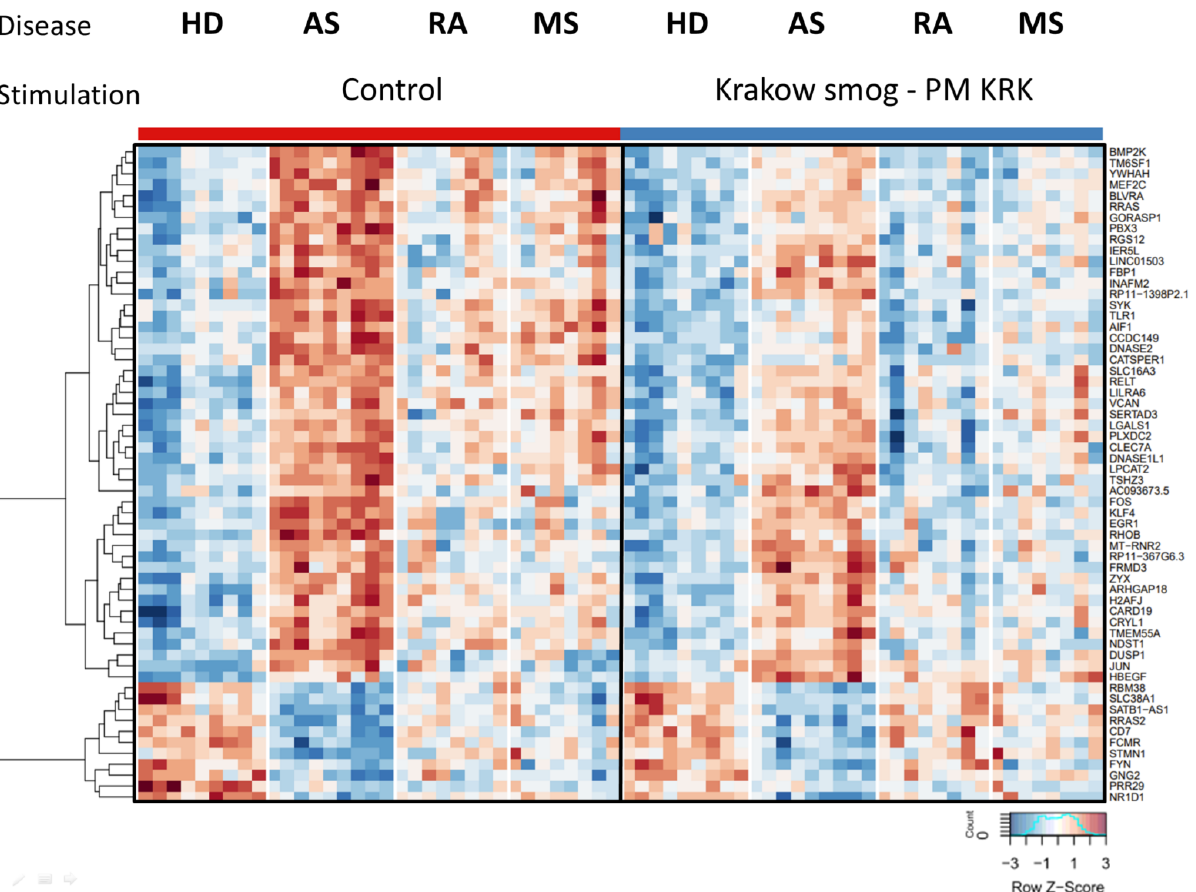
Figure 4. Gene expression differences between the response of PBMCs derived from HD, RA, MS, and AS to PM KRK treatment. RNAseq results are shown as a heatmap and include transcripts with a genome-wide significance from two-way ANOVA for the interaction (FDR corrected p < 0.01) and the difference between disease or stimulation group vs. the appropriate control (a fold of change log 2 > 1). The intensity of the coloured rectangles represents transcript abundance levels. The presented level is proportional to the row z-score values (between − 3 and 3) as displayed on the bar below the heatmap image. Hierarchical clustering was performed using correlation as a distance measure. The full list of differentially expressed transcripts is presented in Table S1.